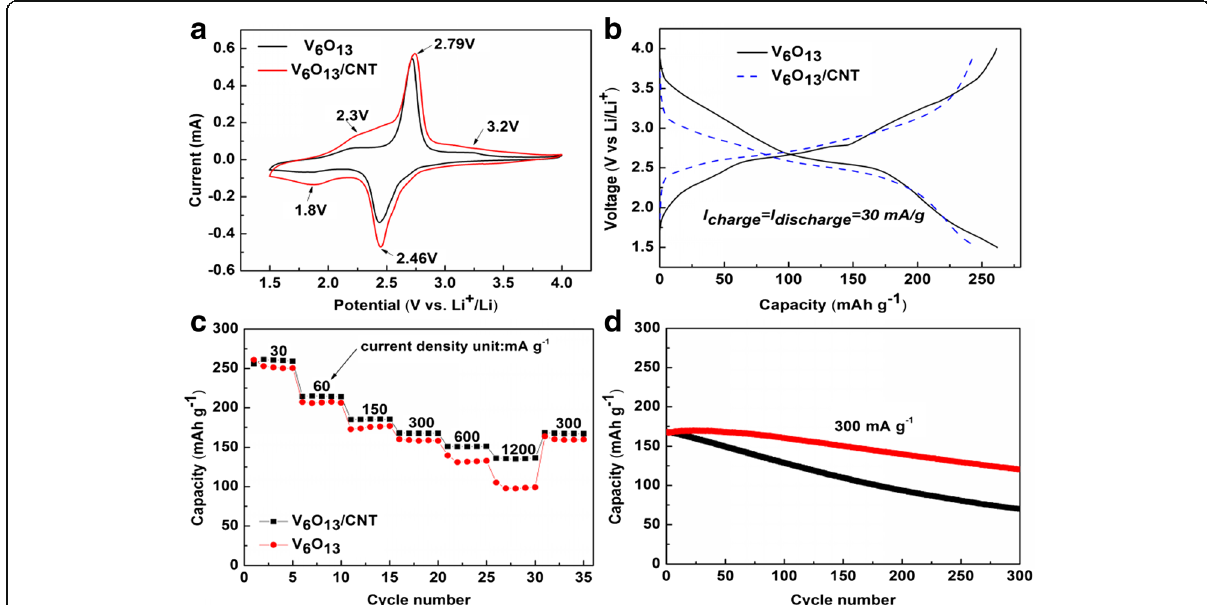
Fig. 4 Electrochemical performance of 3D free-standing V 6 O 13 electrodes with/without CNT coating. a Cyclic voltammetry curves. b Galvanostatic charge/discharge curves. c Rate. d Cyclability performance of the two electrodes